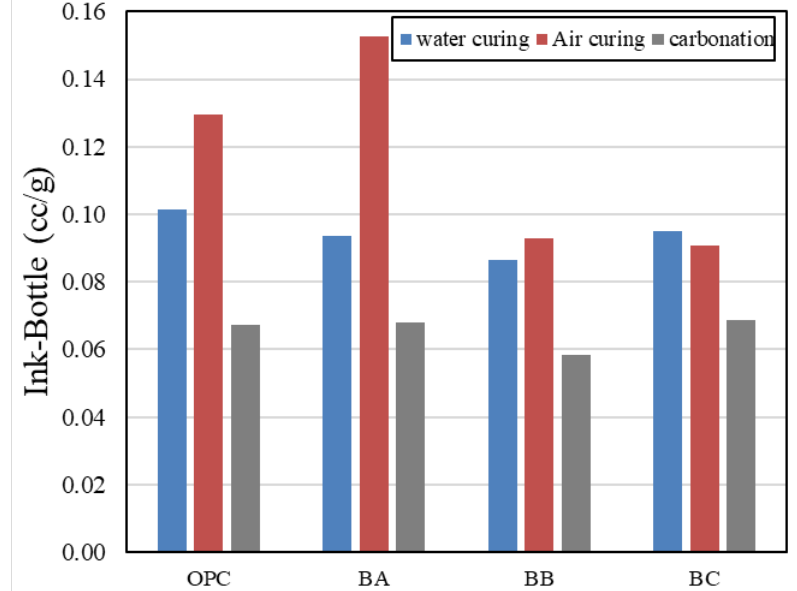
Figure 10. Ink-bottle volume of carbonated cement paste.